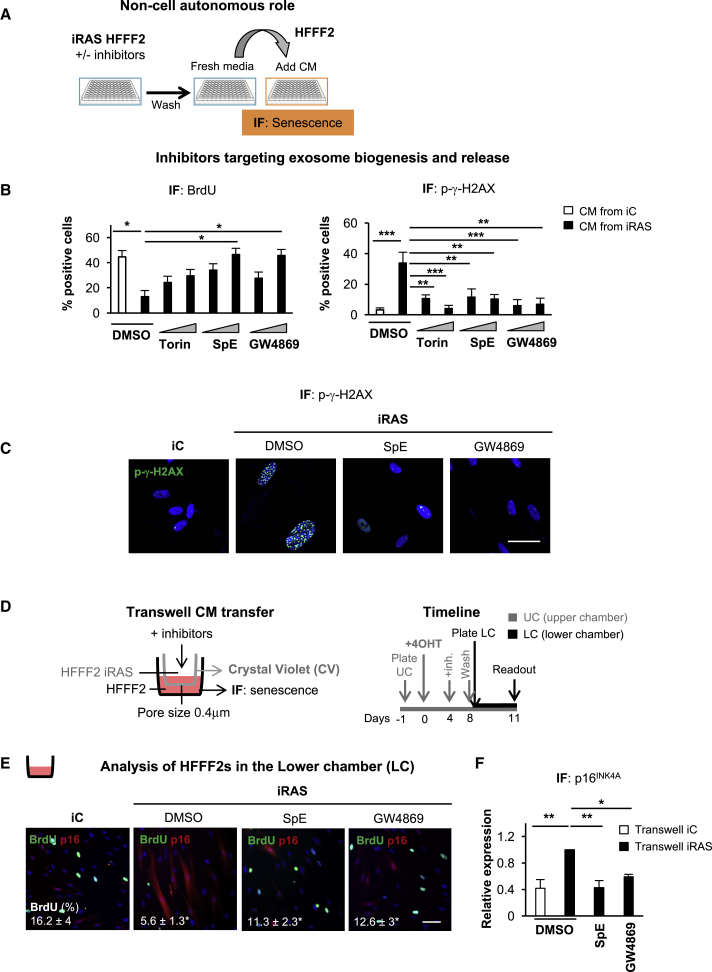
Inhibition of the Enzyme Neutral Sphingomyelinase, N-SMase, Prevents Paracrine Senescence(A) Schematic representation of the experimental settings to determine whether inhibition of N-SMase influences paracrine senescence. iRAS cells were treated with 200 nM 4OHT for 2 days, followed by treatment with different concentrations of Torin-2 (25 and 50 nM) or 2 independent N-SMase inhibitors: GW4869 (1 and 10 μM) and SpE (2 and 5 μM) for 3 days. After the incubation with the inhibitors, cells were washed and allowed to produce fresh CM for 72 h. Normal HFFF2s were then incubated with this CM for a further 72 h.(B) CM-treated HFFF2 fibroblasts were then stained to assess for the percentage of cells expressing markers of senescence: incorporation of BrdU and p-γH2AX by IF (means ± SEMs of 3–4 experiments; one-way ANOVA).(C) Representative pictures for p-γH2AX by IF of HFFF2s treated with the CM from iRAS with or without SpE or GW4869. Scale bar, 50 μm.(D) Schematic representation of the experimental settings and timings to test the implication of small EVs using the Transwell system with a membrane pore size of 0.4 μm.(E and F) The lower chamber was stained to quantify the percentage of cells incorporating BrdU and expressing p16INK4A by IF. Representative pictures and the quantification of BrdU incorporation (E) and p16INK4A (F) are shown. Scale bar, 100 μm. One-way ANOVA test was performed.All data show the means ± SEMs of 2–3 independent experiments.See also Figure S3.